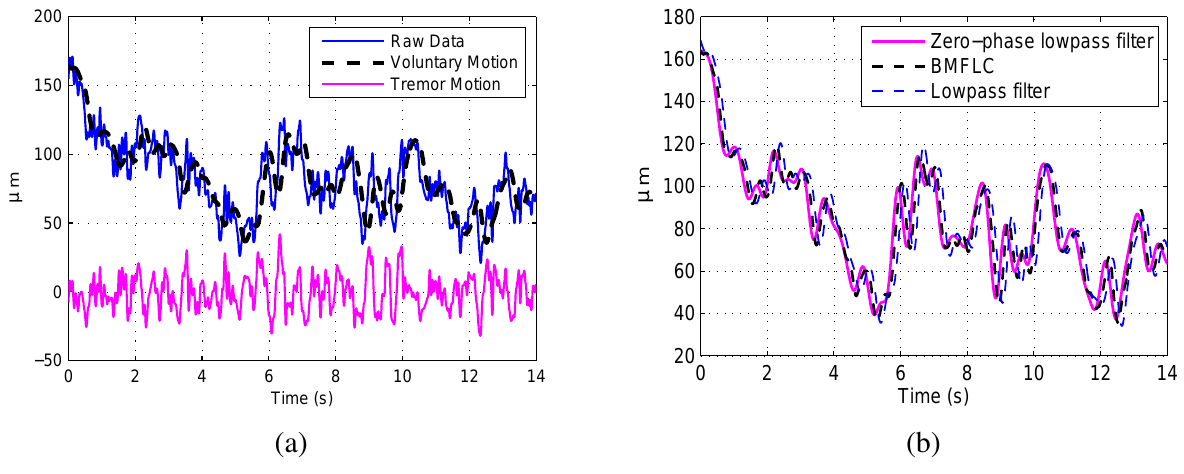
Figure 6. (a) Raw data recorded from Surgeon #1 with pointing task and the identified voluntary motion; (b) Comparison with Lowpass